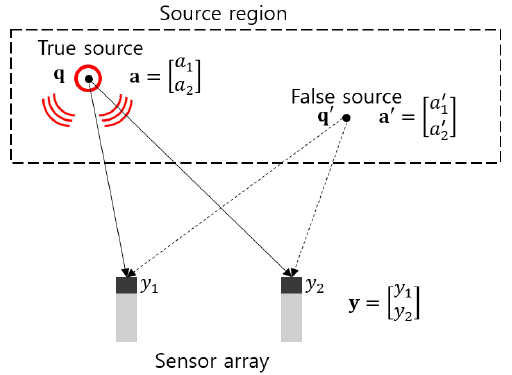
Figure 1. Example of the beamforming